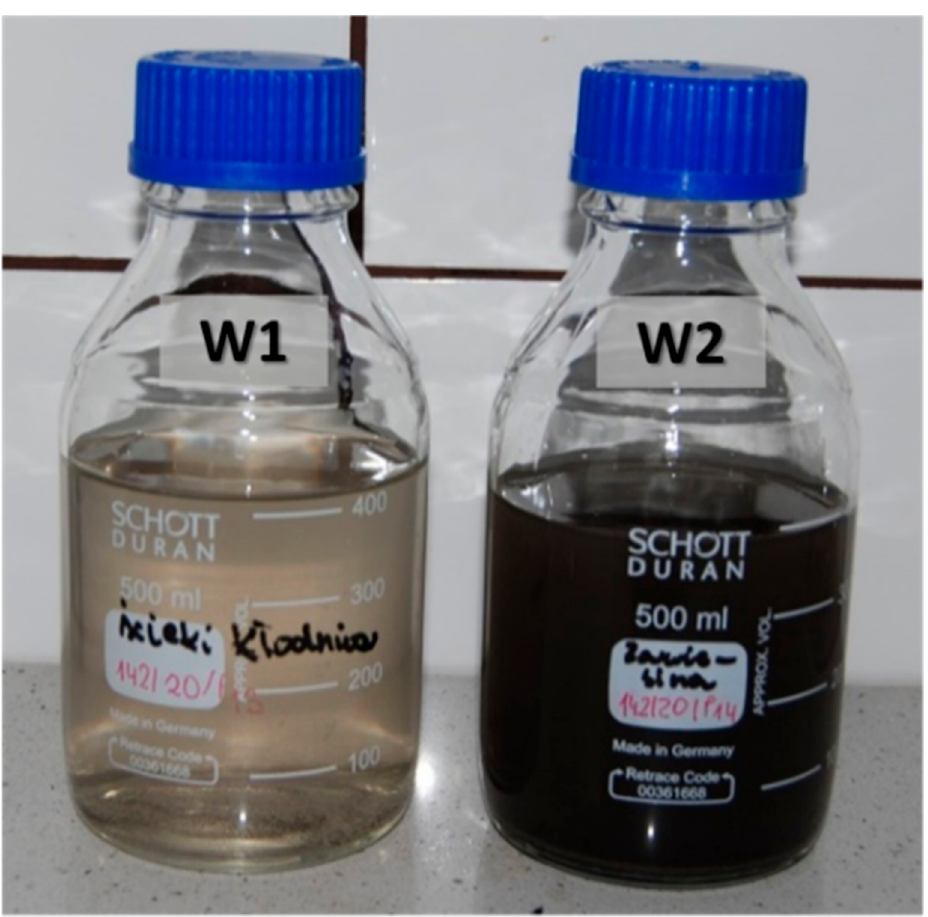
Figure 9. Water and suspension samples taken in March 2020 from the Kłodnica river; flowing water (W1) and water collected at the bottom of the river (W2).